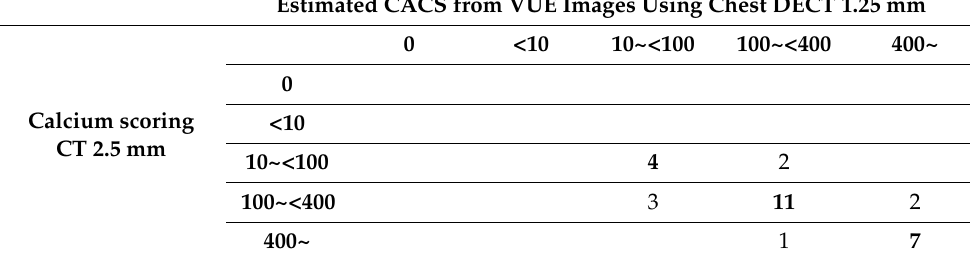
Table 6. Sectional analysis of CACS of CT and estimated CACS from VUE images using chest DECT with 1.25 mm slice thickness and the first-order linear regression